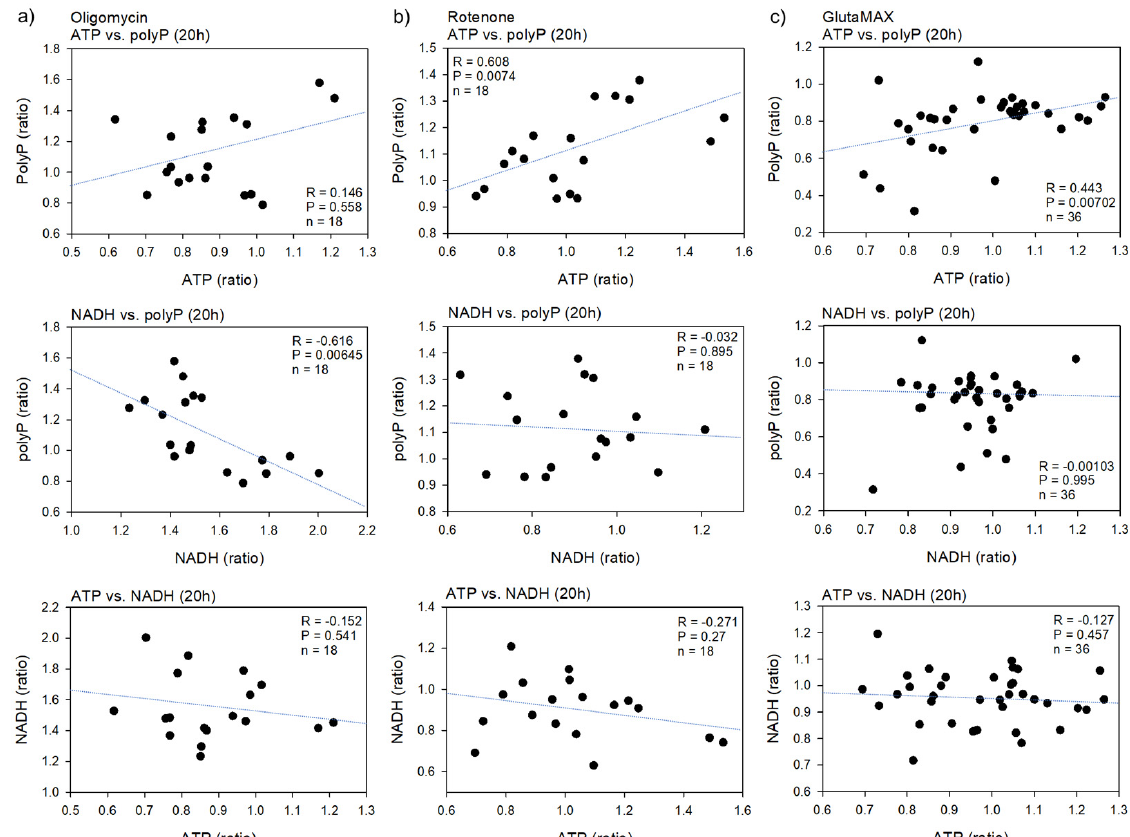
Figure 6. The correlations between polyP levels and ATP levels or NADH levels and between ATP levels and NADH levels in platelets treated with oligomycin ( a ), rotenone ( b ), or GlutaMAX ( c ) for 20 h. Spearman’s rank correlation coefficients were calculated for the evaluation of their correla- tions.